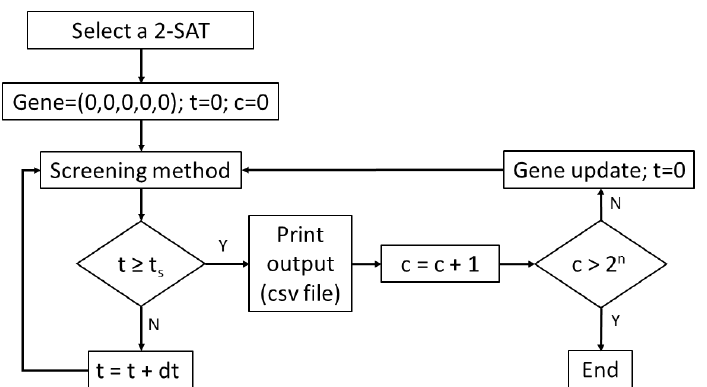
Figure 8. Flowchart of the 2-SAT (2-Satisfiability) problem implemented in Gro language. A list ( gene ) whose elements are the variables of the Boolean expression φ is initialized as (0, 0, 0, 0, 0). At this step, c (gene in decimal notation), which is a variable used for controlling the update of gene, is set to 0 along with the time t . Thereafter, the routine calls the screening method in order to calculate the fitness for the gene . Note that the flowchart shares the topology with the knapsack instance (Figure 7) but with c as the control variable. In the output of the routine in Gro, the gene value is the number of variables that satisfy expression φ while the total amount of GFP or fitness is given by multiplying the mean GFP fluorescence by the colony size (total number of synthetic bacteria).